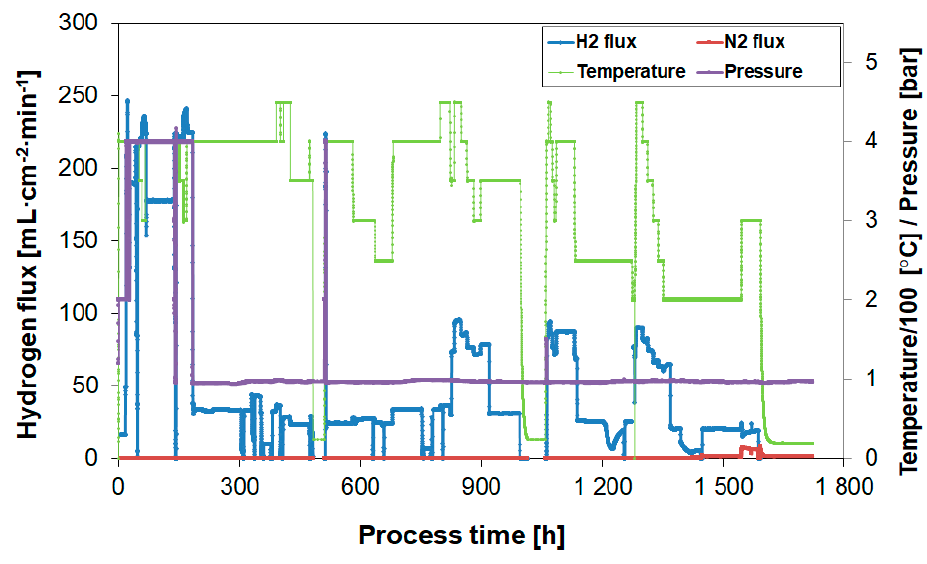
Figure 11. Membrane module #1; 1600 h operation up to 450 °C and 4 bars.